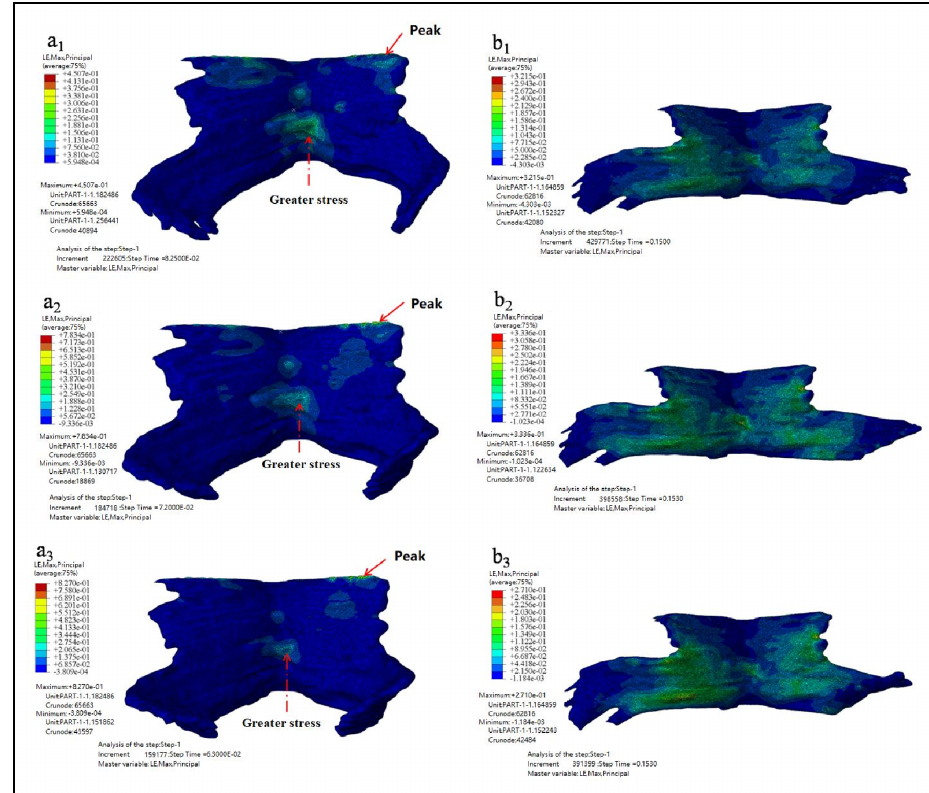
Figure 8. The maximum principal strain nephogram. (a1–a3 showed the maximum principal strain nephogram of Mod- els D80, D90, and D100 while b1–b3 showed the principal strain nephogram of Models D80, D90, and D100 at simulation nephogram of Models D80, D90, and D100 while b1 – b3 showed the principal strain nephogram of end time of 0.15s) Models D80, D90, and D100 at simulation end time of 0.15 s).